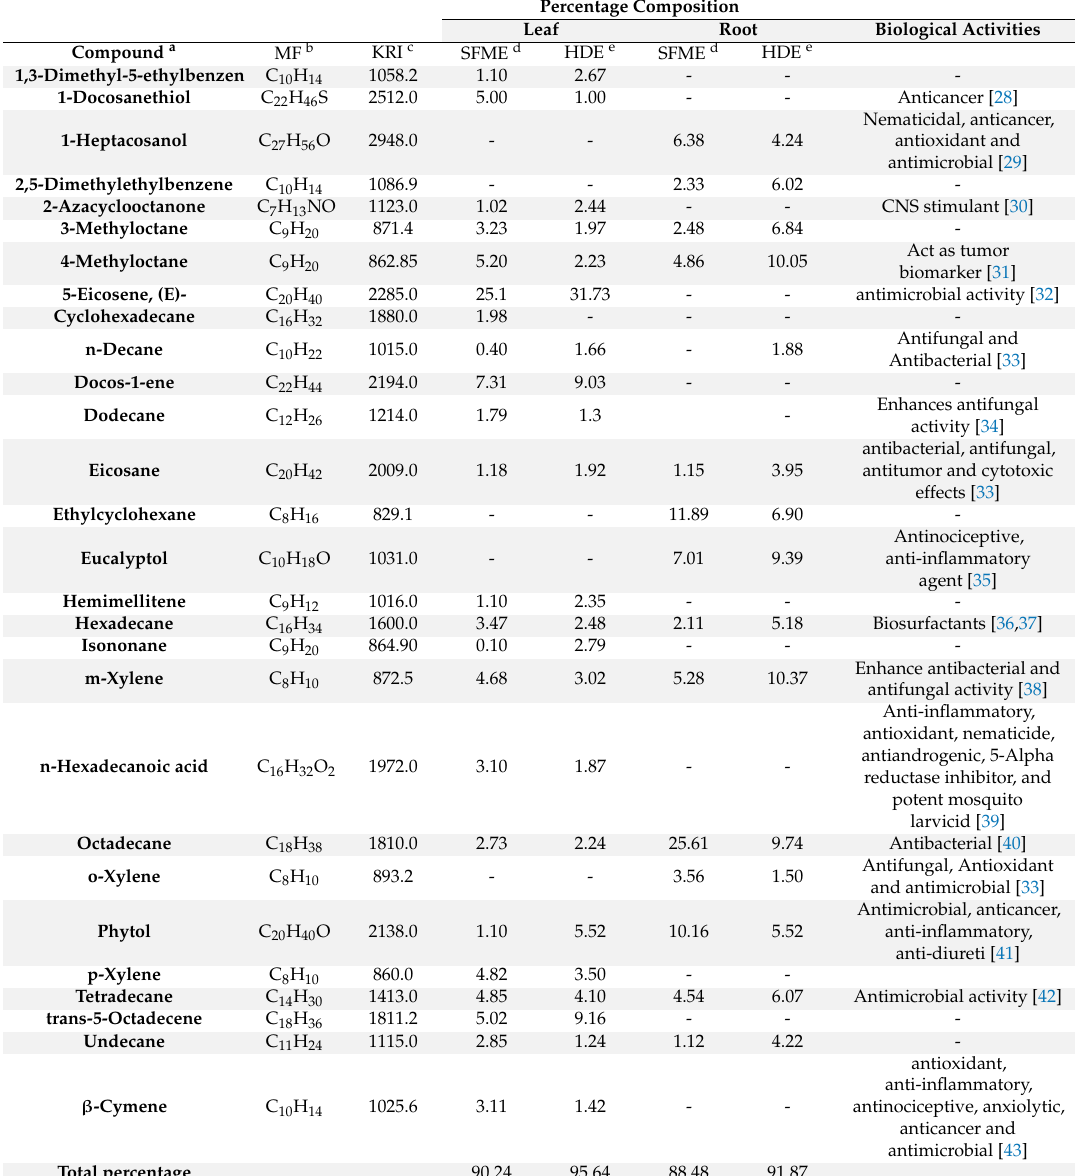
Table 3. Chemical composition of the essential oil of R.